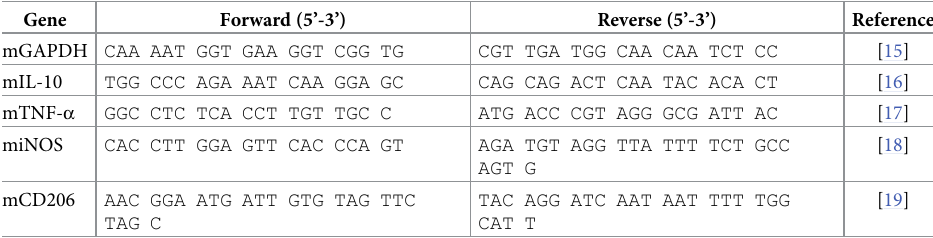
Table 1. Sequences of PCR mouse primers used in this